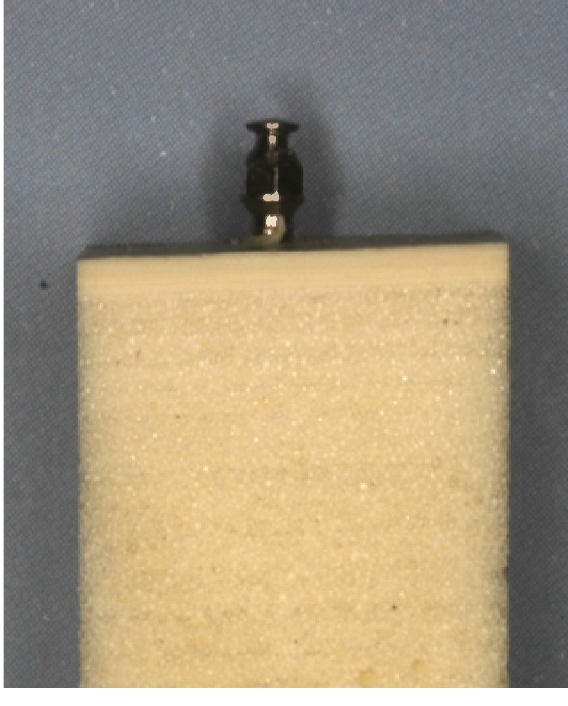
Figure 2. Photograph of an MI inserted in synthetic bone block with 1-mm-thick cortical bone